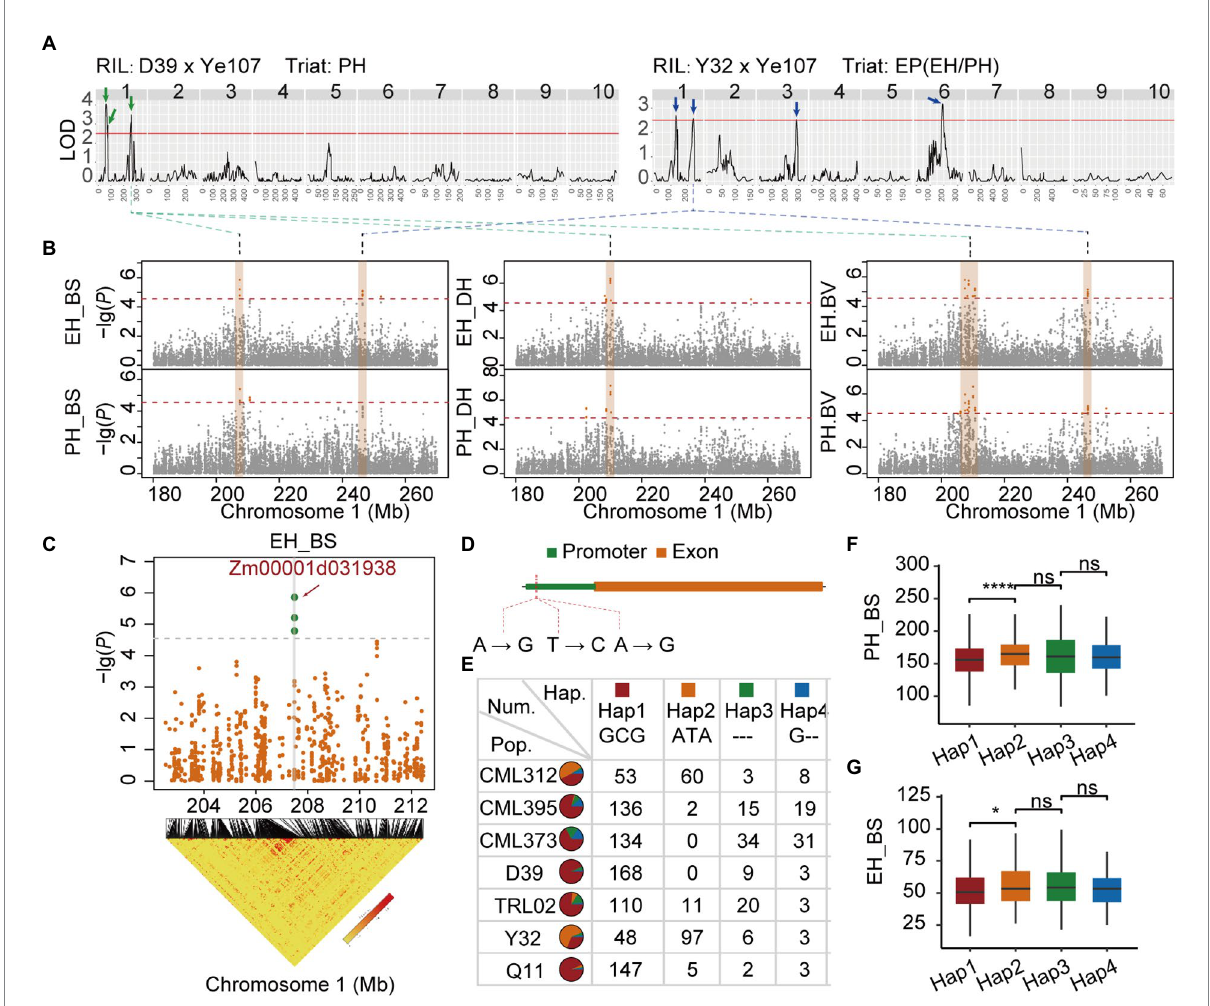
FIGURE 7 (A) QTL mapping of PH in D39 × Ye107 and EP in Y32 × Ye107. (B) Locus in Manhattan by GWAS. (C) Linkage disequilibrium block of Qtl-chr1-EP . (D) The three SNPs in the loci and the distribution ratio of the four haplotypes in seven RILs (E) . The PH (F) and EH (G) of the four haplotypes in